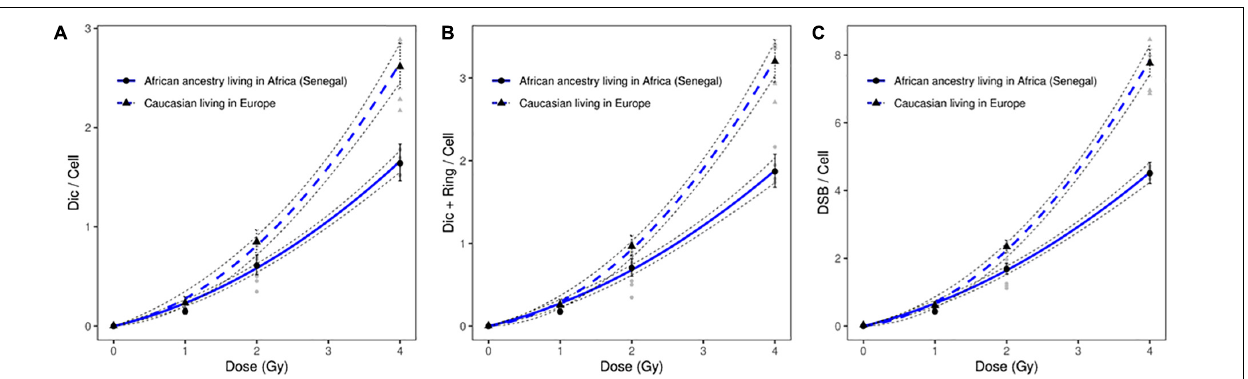
FIGURE 2 | Dose response curves obtained after X-ray irradiation of circulating lymphocytes in vitro of healthy donors of African ancestry living in Africa (Senegal) and European ancestry living in Europe after scoring of (A) dicentric chromosomes (B) dicentric and ring chromosomes, and (C) calculated DSBs. The mean numbers of chromosomal aberrations with 95% confidence intervals of each population are shown. Individual values for each of the donors are also plotted, as well as the standard errors (dotted line).